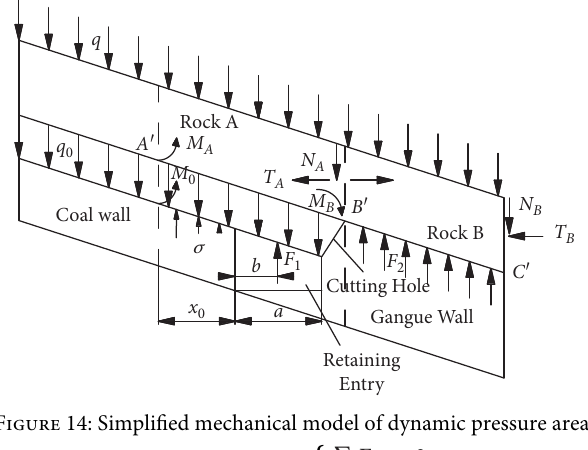
Figure 14: Simplified mechanical model of dynamic pressure